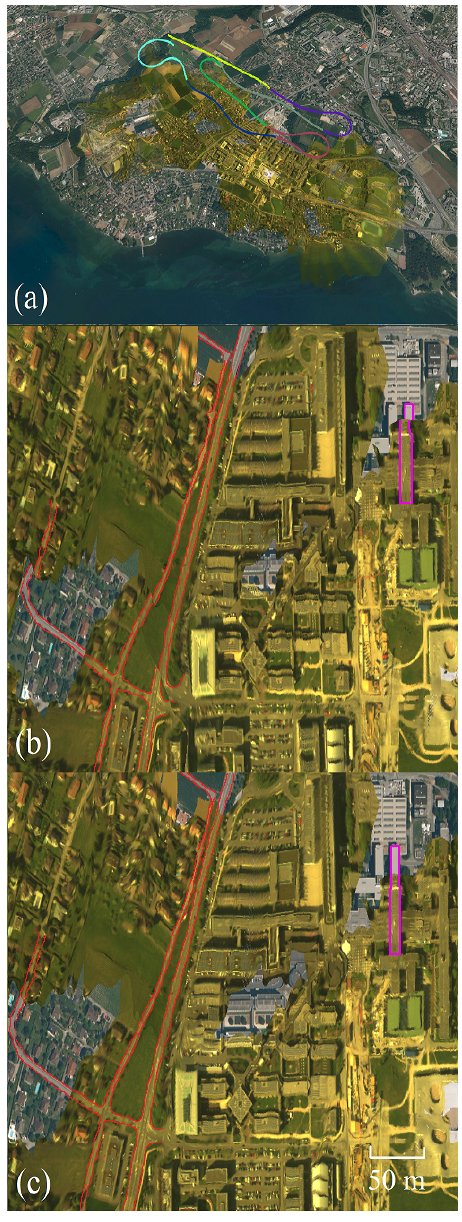
Figure 6. (a) flight path and extract from the projection (b) before and (c) after correction, for flight 1 (EPFL, Lausanne, Switzer-